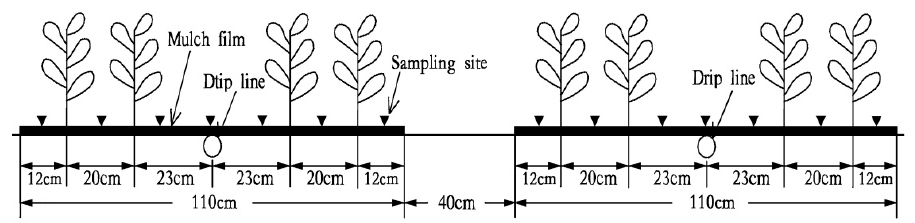
Figure 2. Schematic diagrams of cotton planting, mulching pattern, dripper location, and sampling sites.